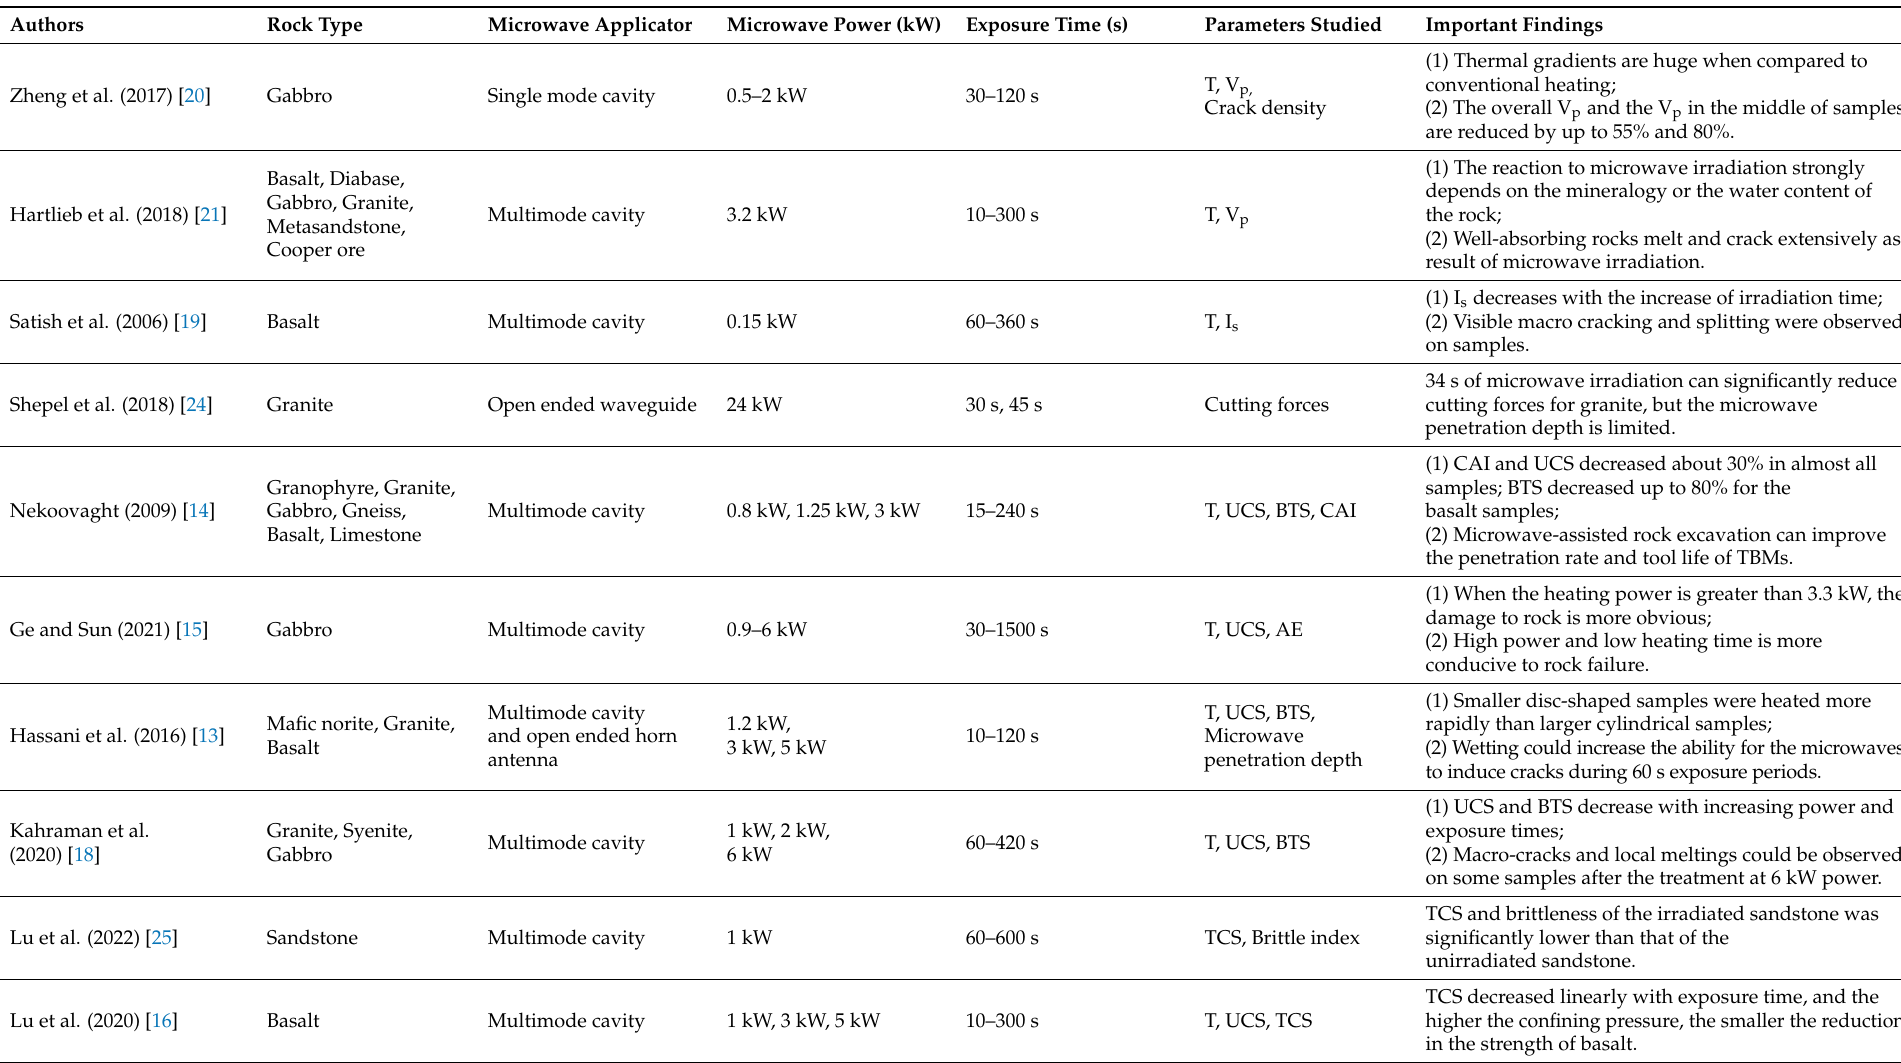
Table 1. Summary of experimental studies on microwave treatment of rock